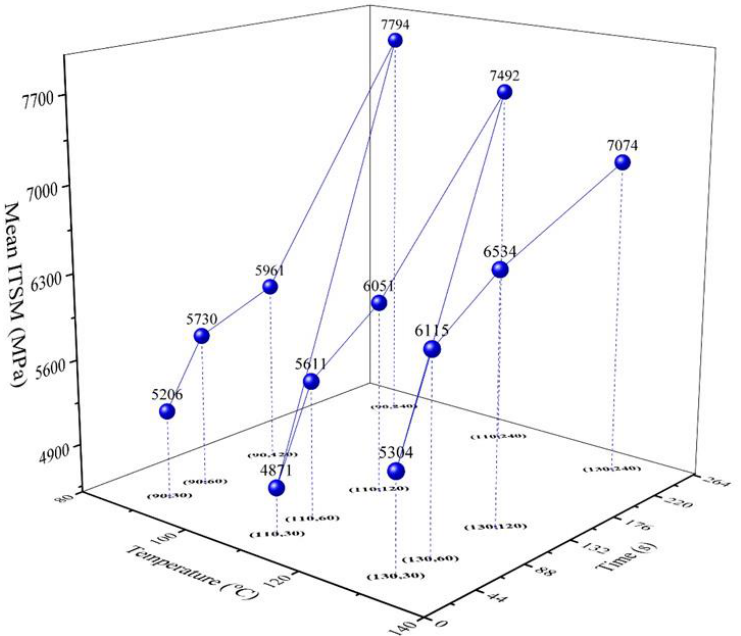
Figure 7. The average ITSM versus mixing temperature and time. Similarly, the high stiffness obtained at a low temperature might be attributed to the low blending degree between the aged bitumen and the new bitumen. In contrast, mixing the asphalt mixture at high temperatures accelerated the diffusion between the aged bitumen and the new bitumen. Hence, a high stiffness modulus was observed at low